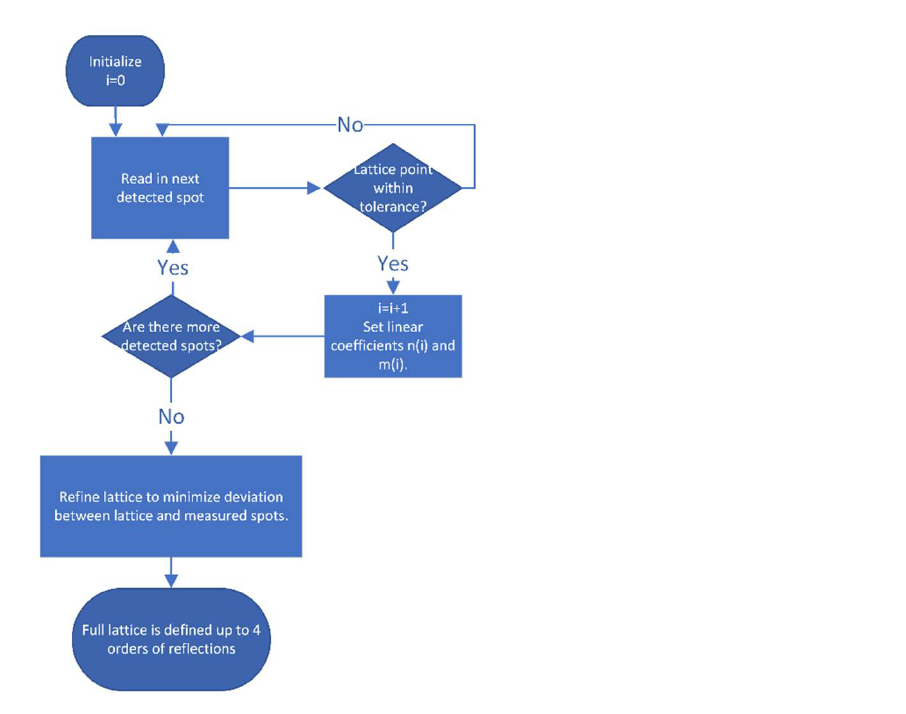
Figure 3. Block diagram showing the steps of fitting the full lattice to the measured subset of spots.